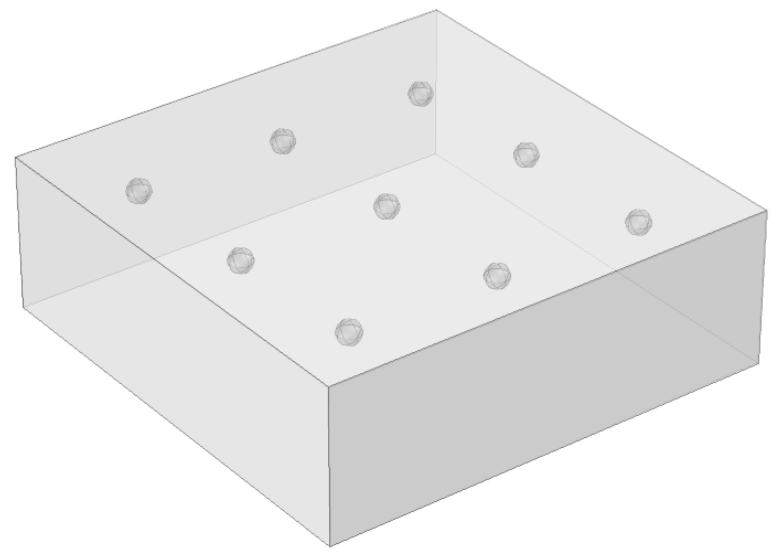
Figure 4. Scheme of sample with sphere-like defects ( D = 3 mm).